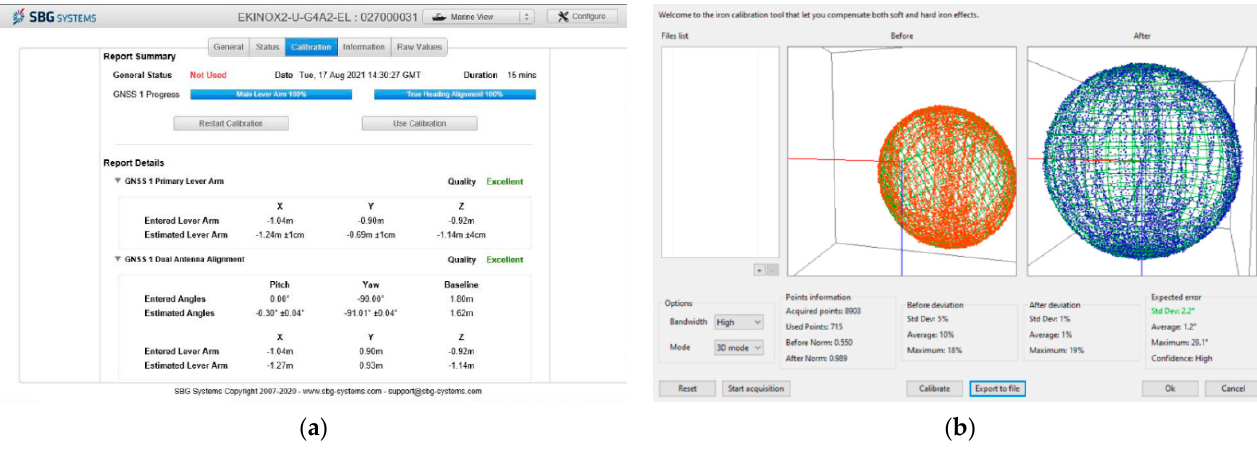
Figure 4. The calibration results of the GNSS/INS systems, models ( a ) Ekinox2-U and ( b ) Ellipse-D as of 19 August 2021.